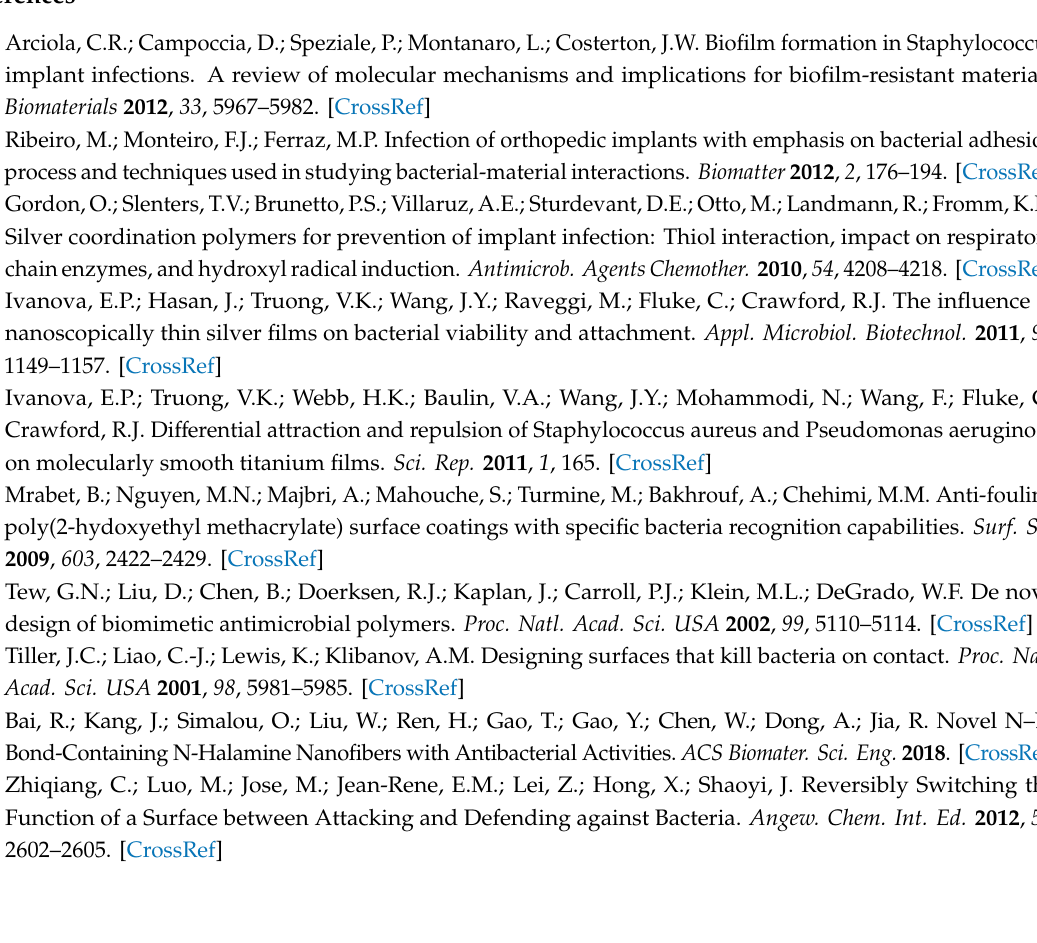
Figure S2: Elemental mapping images of a single ZnO nanowire. Figure S3: Fluorescence images of ZnO film and ZnO nanowire substrate for the antibacterial test before and after washing